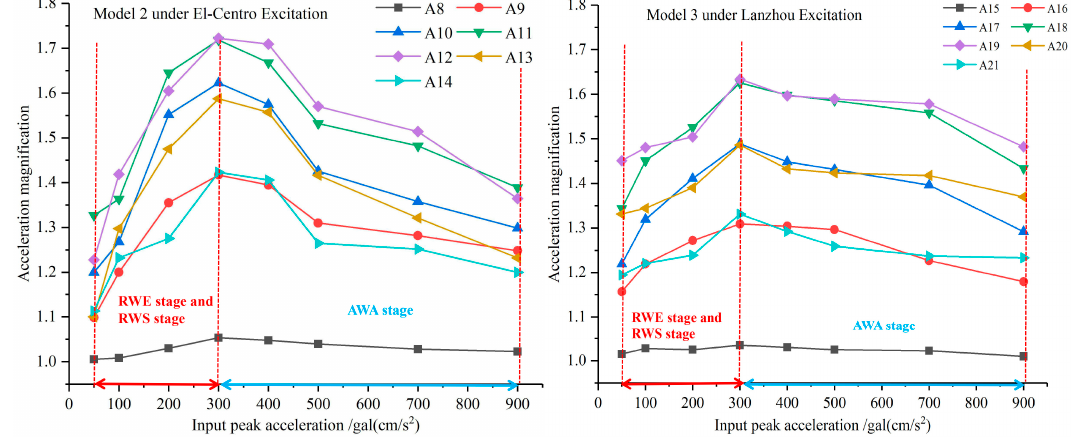
Figure 12. Relationship between HAM and input peak acceleration.